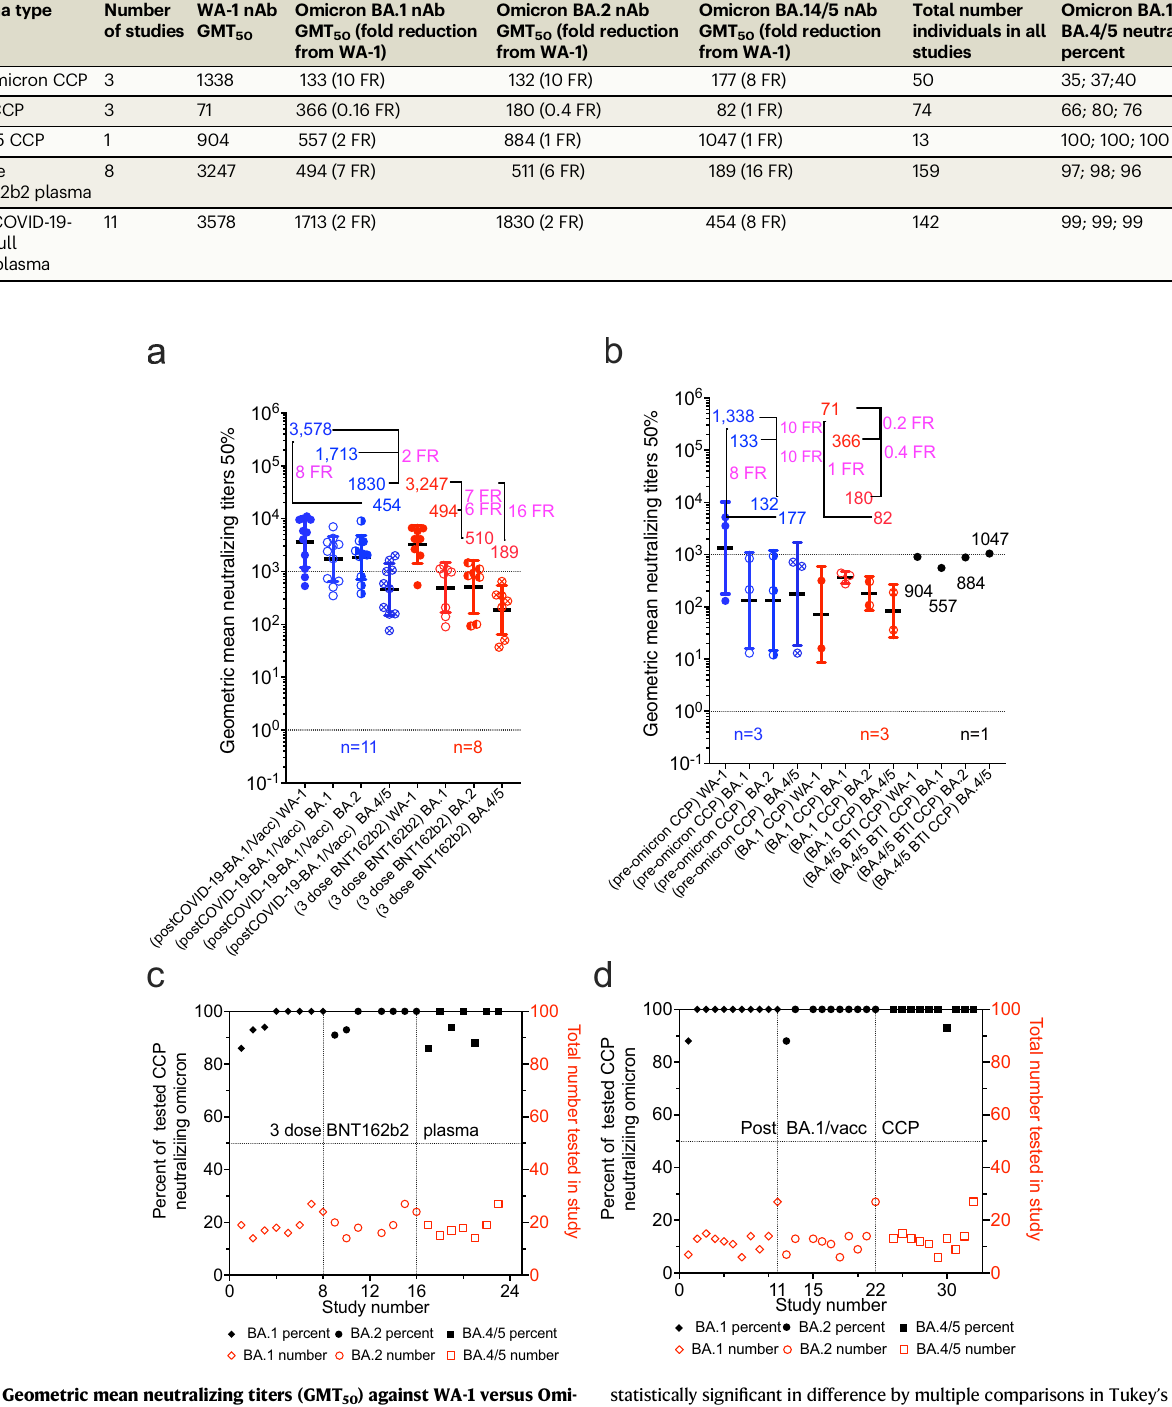
statistically signi fi cant in difference by multiple comparisons in Tukey ’ s test. The percent of total samples within a study condition which neutralized Omicron graphed in increasing percentages on the left y axis with the number of total samples tested on the right y axis. c uninfected 3-dose vaccine neutralization of Omicron BA.1, BA.2, and BA.4/5; d post-COVID-19-BA.1/post-vaccine (Vax-CCP). Source data are provided as a Source Data fi le.